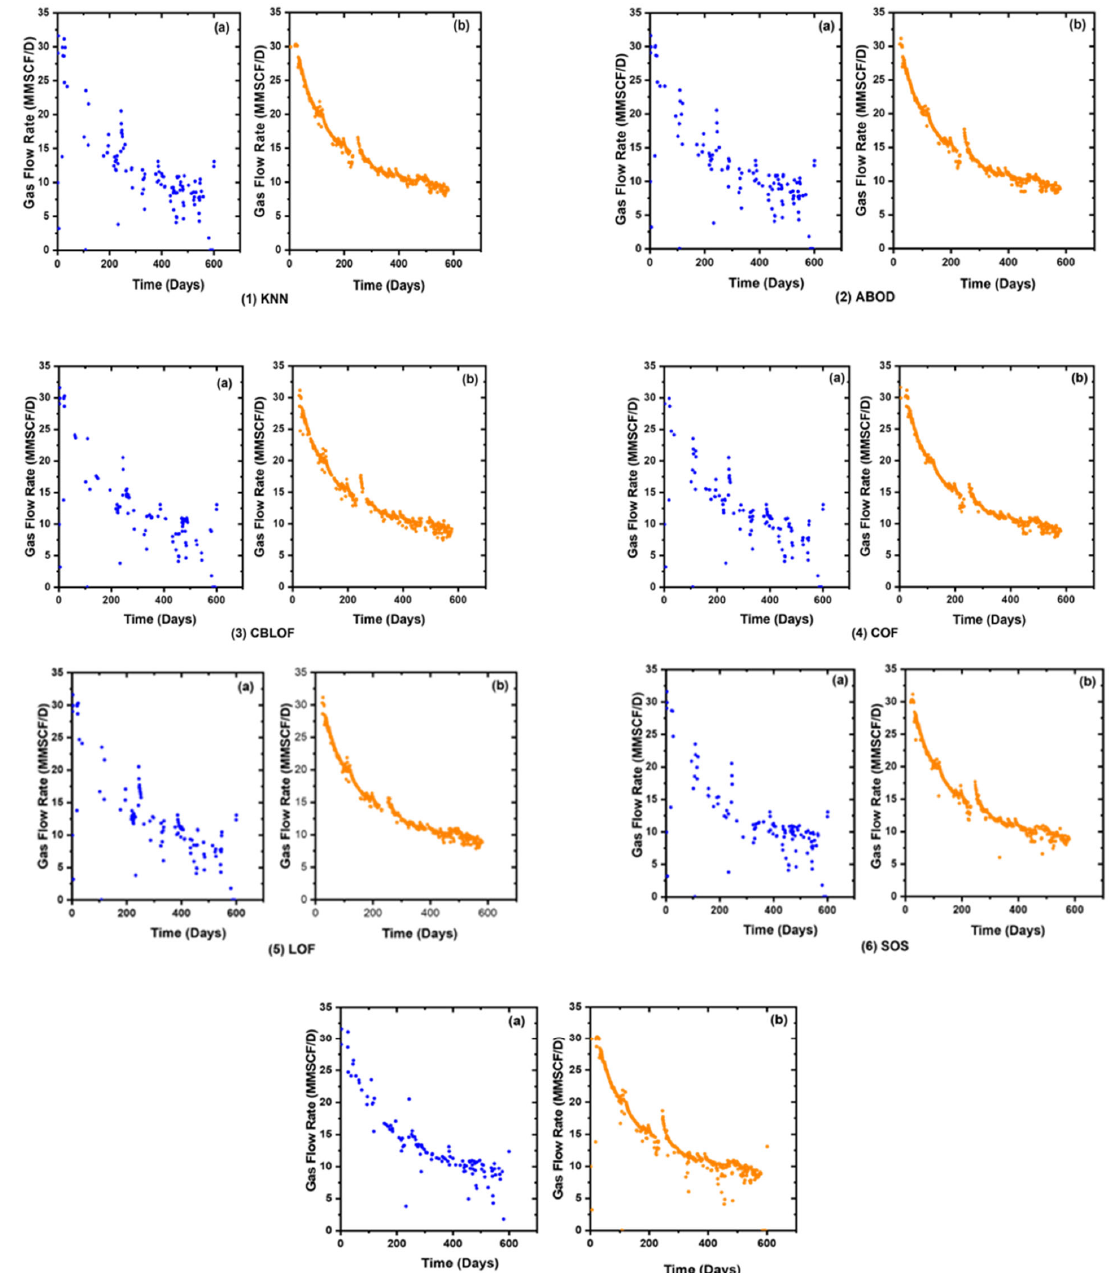
Figure 18. ( a ) Removed outliers and ( b ) production data after removing the outliers of Well_40 using; ( 1 ) KNN, ( 2 ) ABOD, ( 3 ) CBLOF, ( 4 ) COF, ( 5 ) LOF, ( 6 ) SOS, and ( 7 ) SOD algorithms.